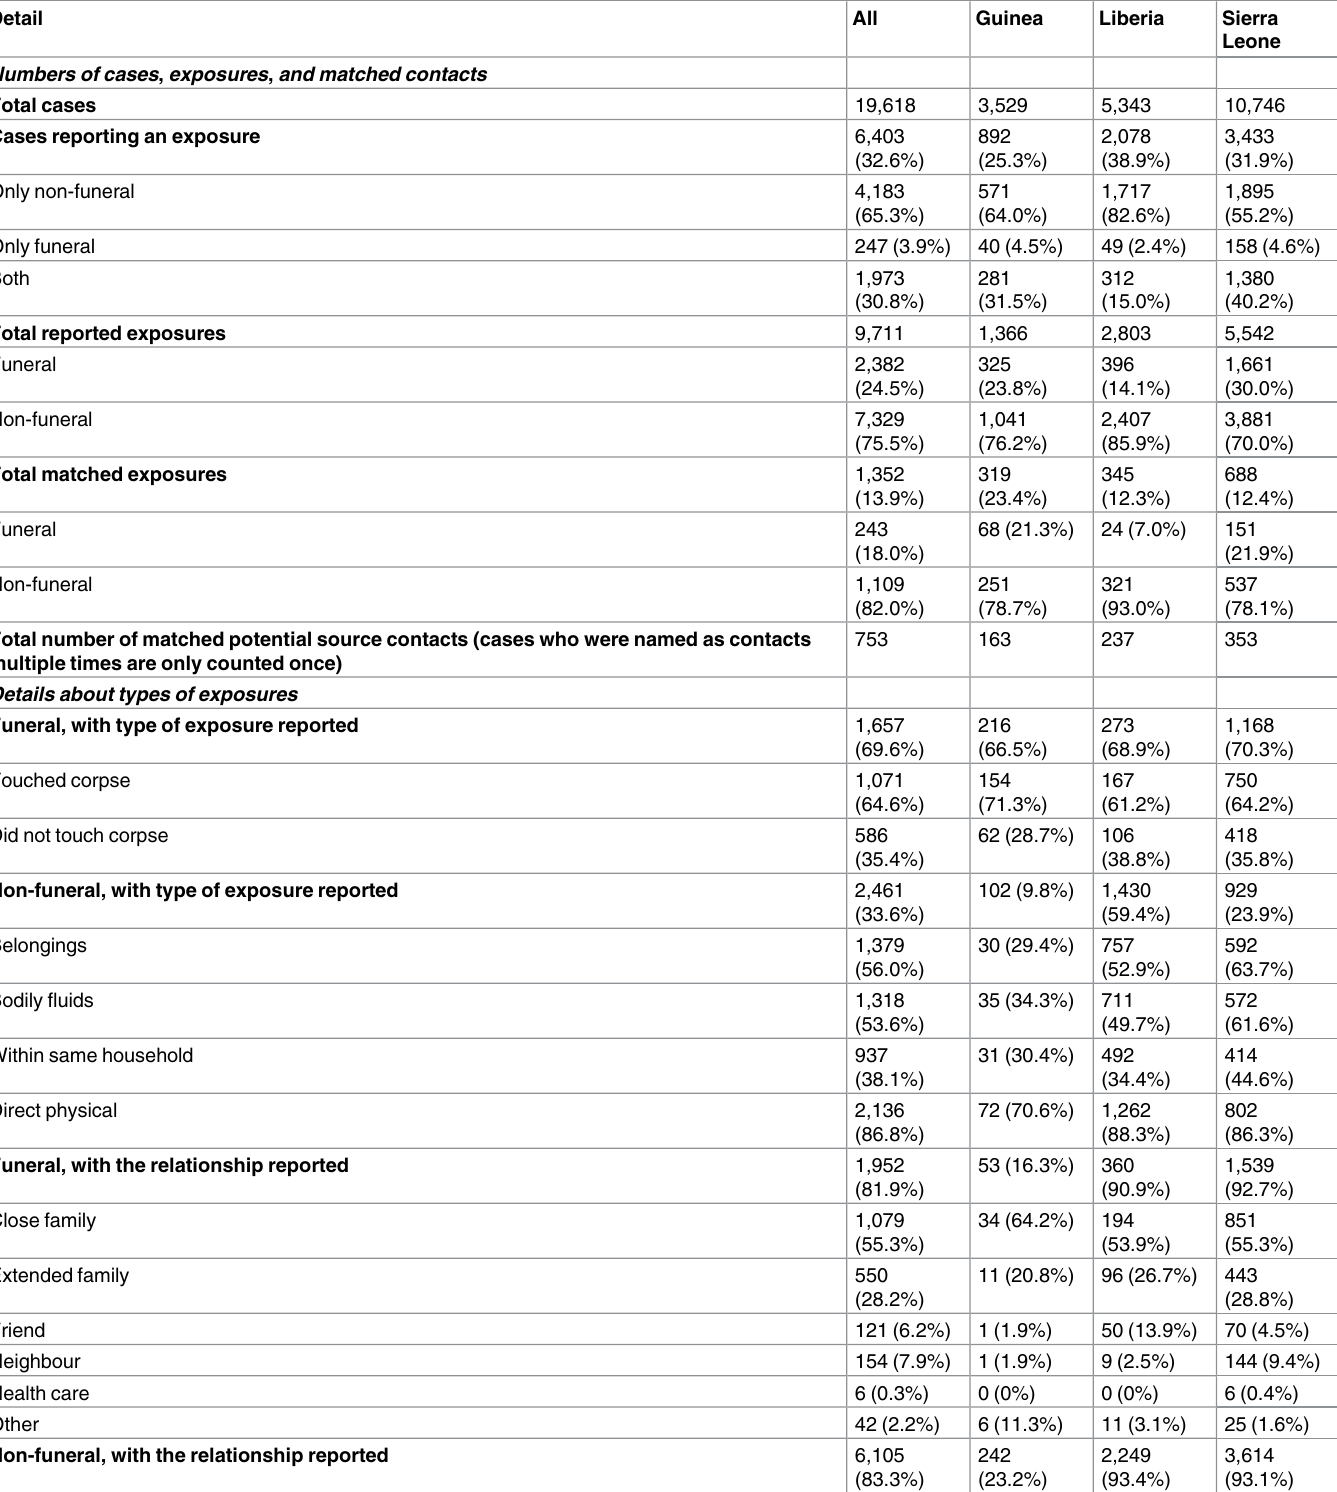
Table 1. Number of confirmed or probable (CP) cases, exposures, and matched CP-CP contacts and details of the type of exposure and the reported relationship between the case and potential source contact.